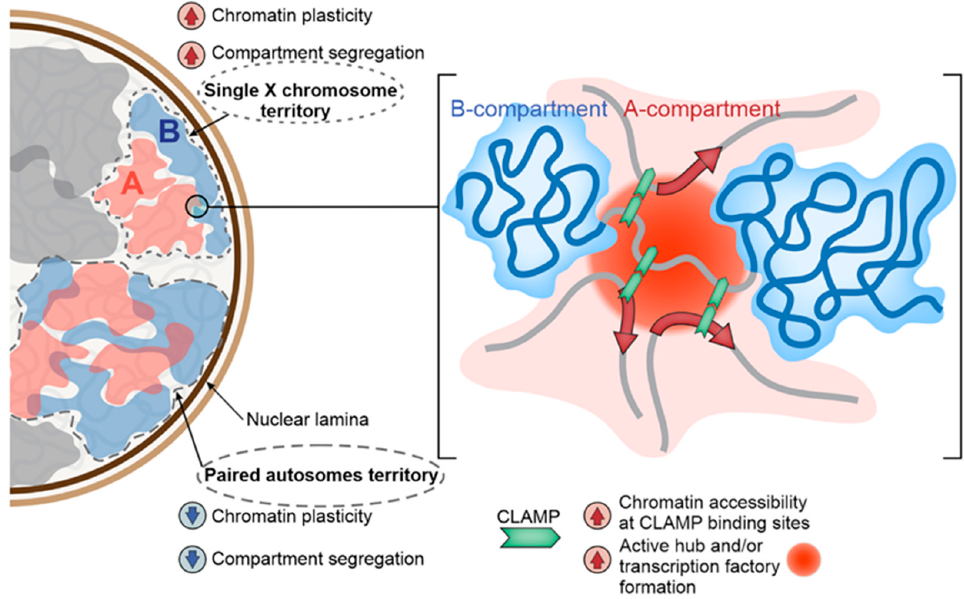
Figure 2. Schematic illustrating mechanisms involved in non-canonical DC. See text for details.